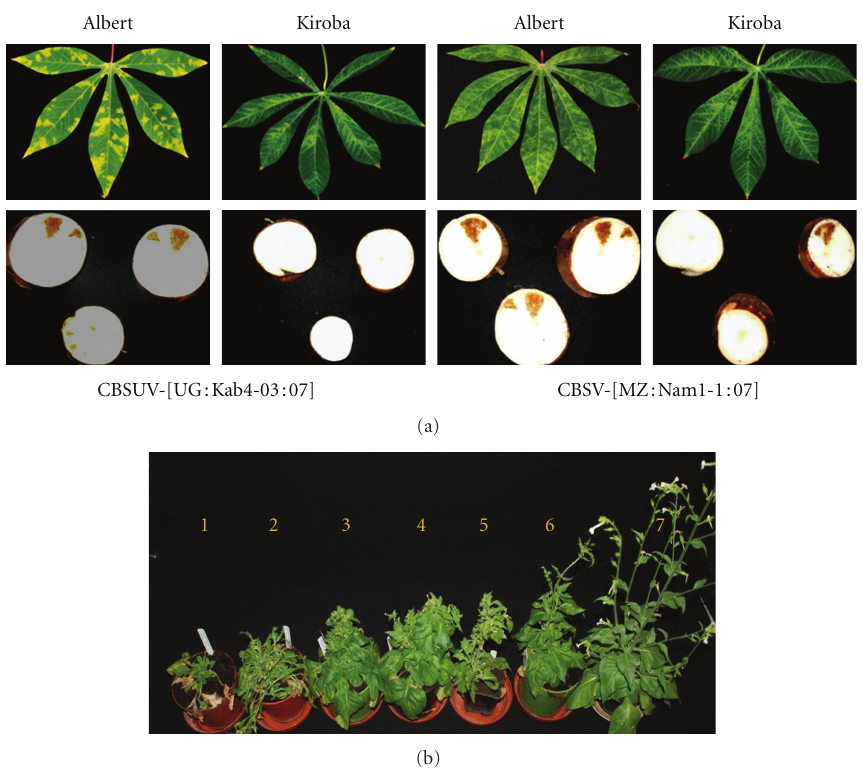
Figure 2: (a) Typical leaf and root symptoms expressed by the CBSUV-[UG:Kab4-3:07] and CBSV-[MZ:Nam1-1:07] in varieties Albert and Kiroba. (b) Typical symptoms observed on N. clevelandii plants 5-6 weeks after inoculated with sap extracted from infected cassava plants. 1 = CBSV-[MZ:Nam1-1:07]; 2 = CBSV-[TZ:Nal3-1:07]; 3 = CBSV-[TZ:Kib10-2:03]; 4 = CBSV-[TZ:Zan6-2:08]; 5 = CBSUV-[KE:Mwa16-2:08]; 6 = CBSUV-[UG: Kab4-3:07]; 7 = healthy control plant.